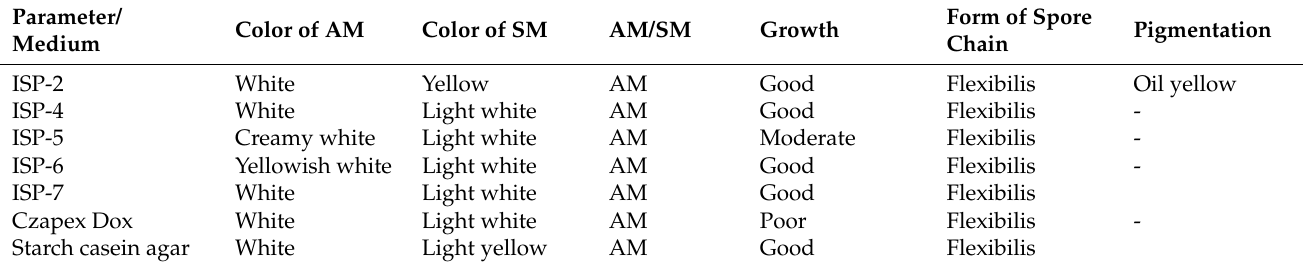
Figure 2. Morphology of Streptomyces sp. strain ess_amH1 in different media: ( A ) ISP-2 medium; ( B ) ISP-4 medium; ( C ) starch casein agar. Table 1. Cultural characterization of Streptomyces sp. strain ess_amH1 on different culture media.